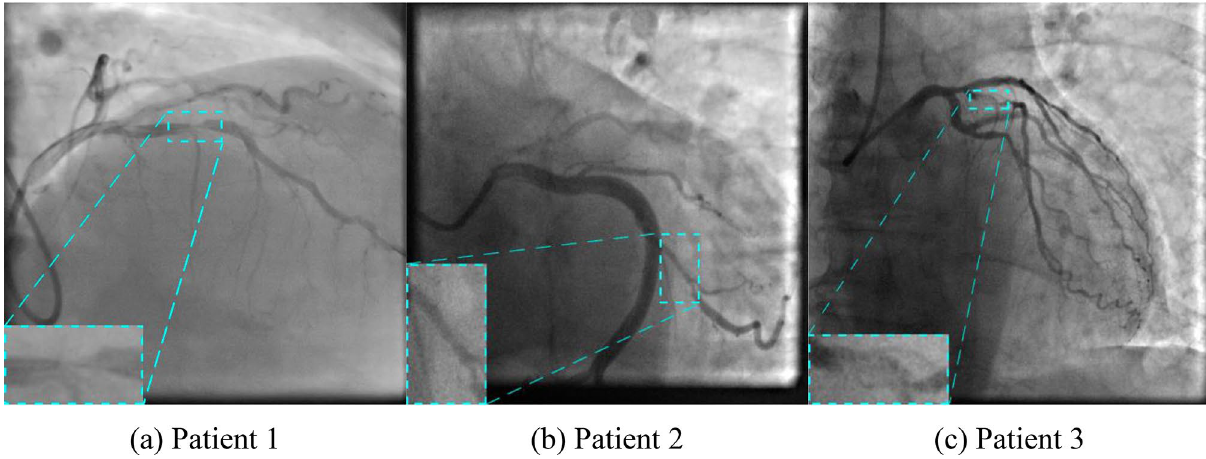
Figure 1. Data labelling of the source images with the callouts of the detected stenotic lesions.